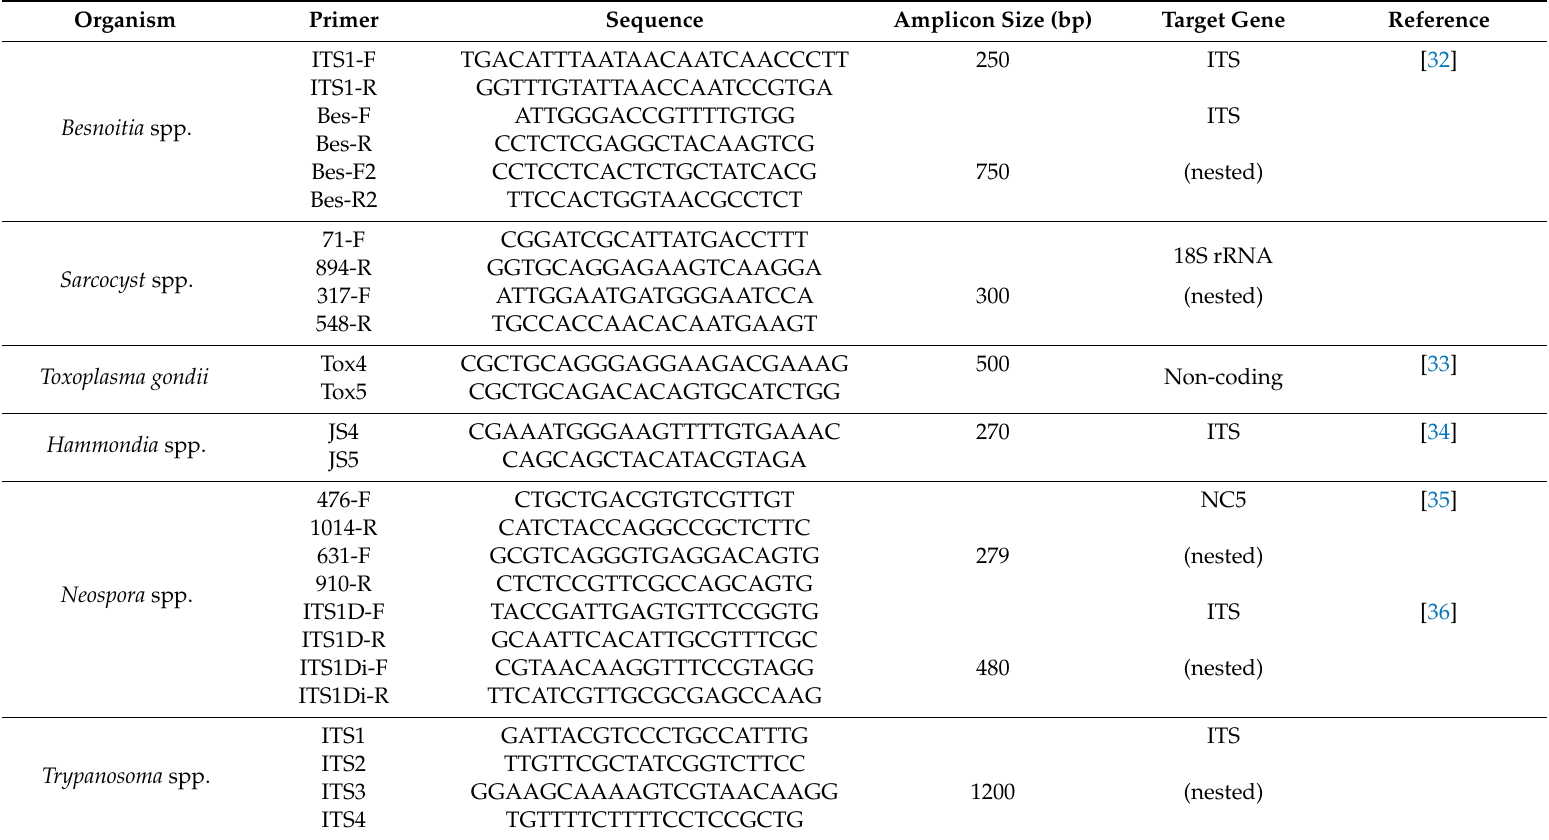
Table 1. The PCR primers used to identify the coccidian species of the tissue cysts found in donkeys’ muscle tissue. Organism Primer Sequence Amplicon Size (bp) Target Gene Reference ITS1-F TGACATTTAATAACAATCAACCCTT 250 ITS [32] ITS1-R GGTTTGTATTAACCAATCCGTGA Bes-F ATTGGGACCGTTTTGTGG ITS Besnoitia spp. Bes-R CCTCTCGAGGCTACAAGTCG